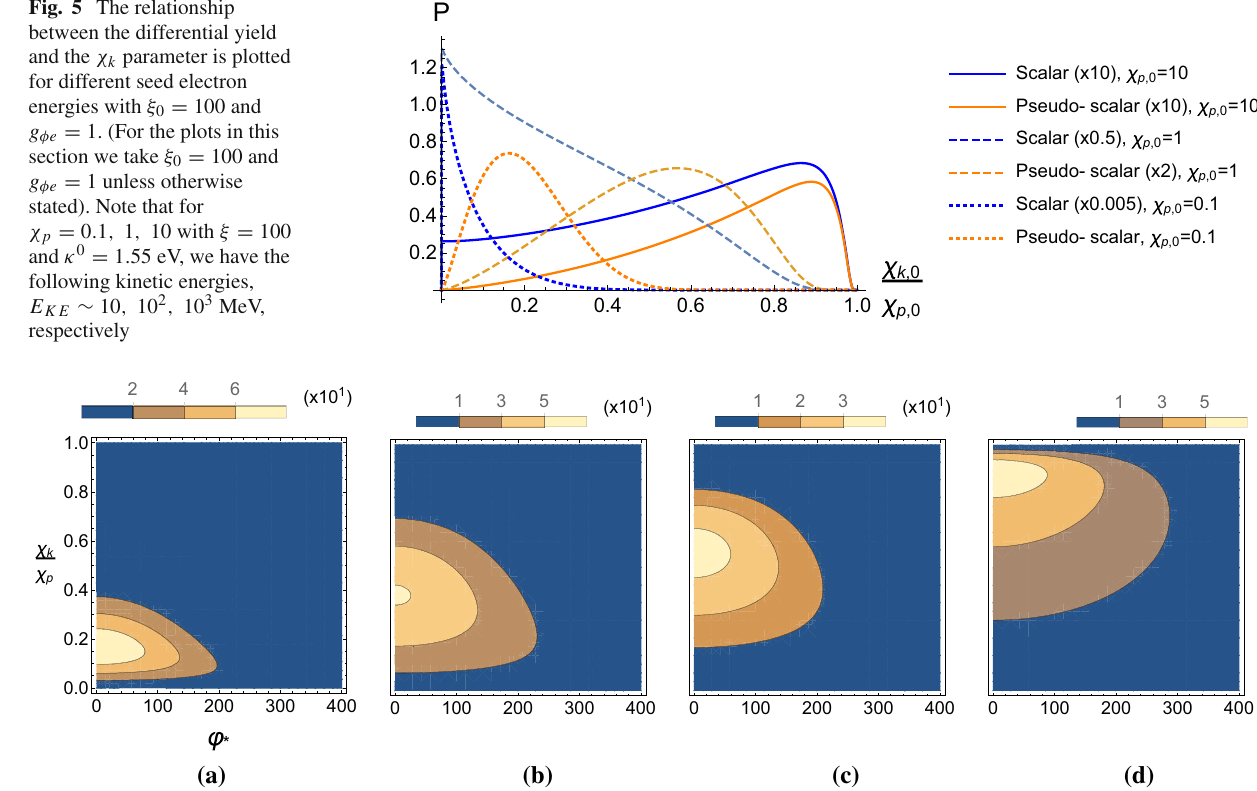
Fig. 6 The pseudo-scalar yield, P − , is plotted as a function of χ k /χ p and the phase ϕ ∗ in a Gaussian background with a pulse duration of 100 fs and m φ = 0. a χ p , 0 = 0 . 1, b χ p , 0 = 0 . 4, c χ p , 0 = 1, d χ p , 0 =